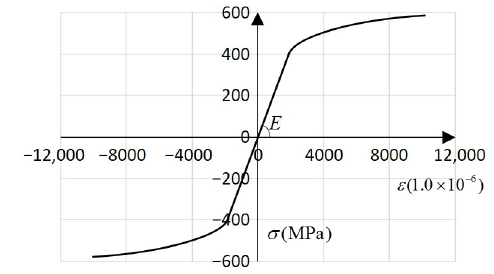
Figure 9. Stress-strain relationship of steel.